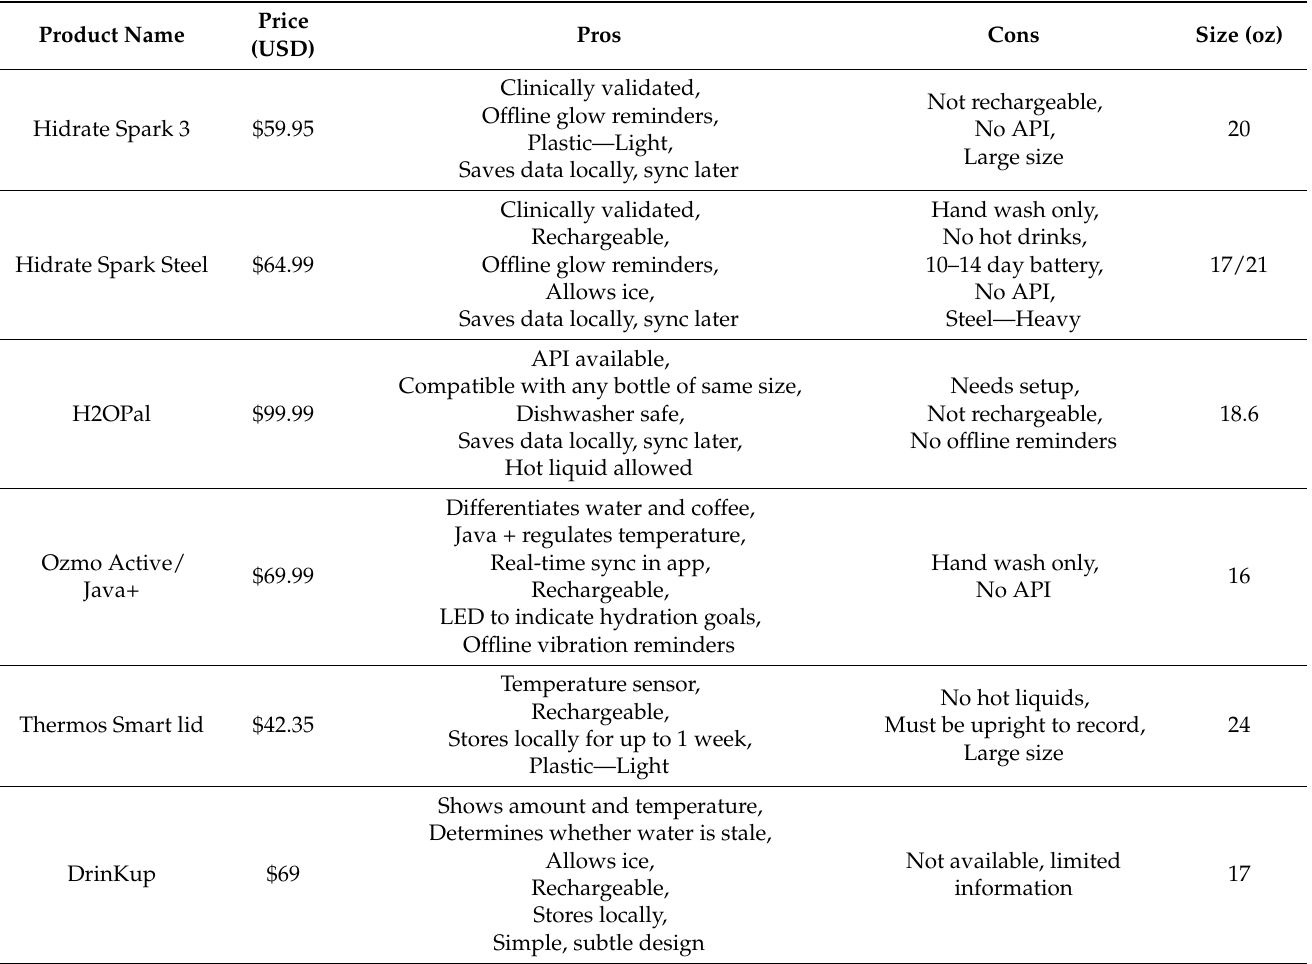
Figure 5. Images of analyzed commercial bottles: ( a ) HidrateSpark 3 [153], ( b ) Hidrate Spark Steel [154], ( c ) H2OPal [132], ( d ) Thermos Smart Lid [155], ( e ) Ozmo Active [156], ( f ) DrinkUp [158], ( g ) HydraCoach [159], and ( h ) Droplet Tumbler [160]. Table 5. Summary of commercial smart bottles.